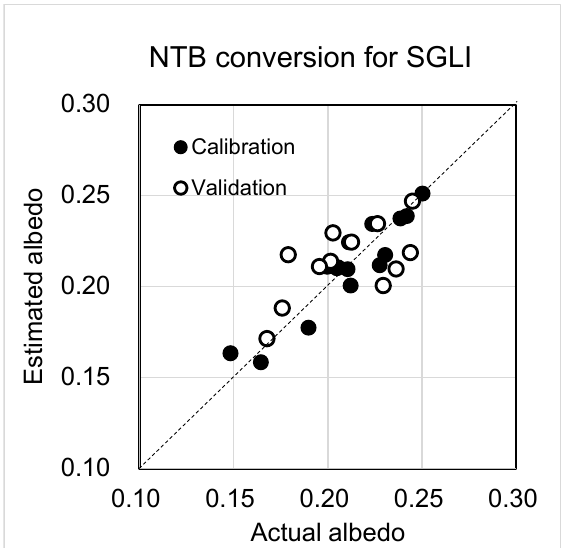
Figure 3. Scattergram of actual albedo versus that estimated by narrow-to-broadband (NTB) conversion for